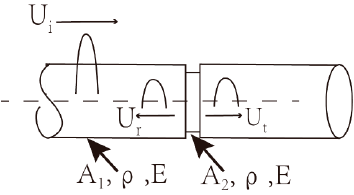
Figure 3. Incident, reflected, and transmitted waves at waveguide junction.